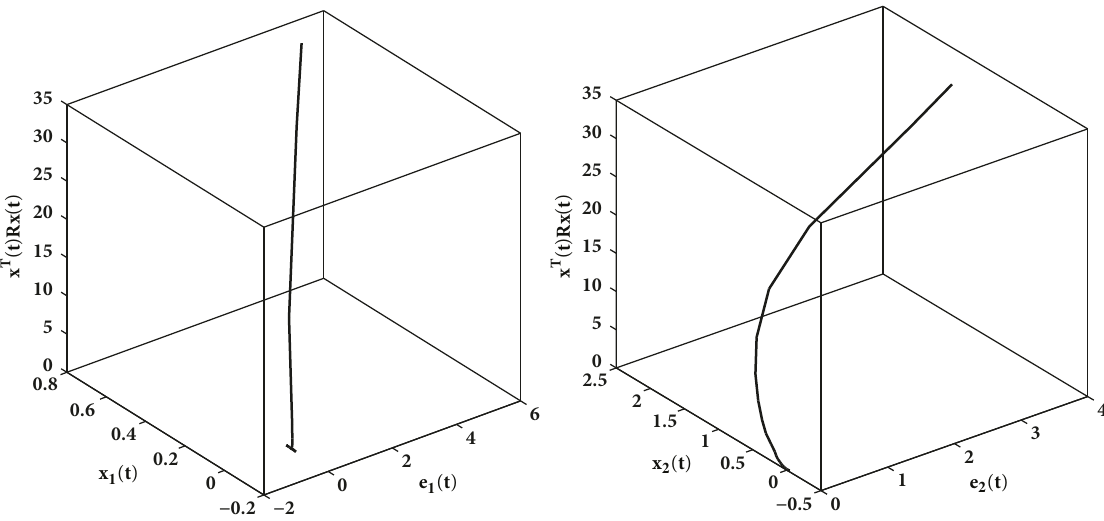
Figure 5: The evolution ̃𝑥 Τ (𝑡)𝑅̃𝑥(𝑡) for 𝑒(𝑡) and 𝑥(𝑡) .